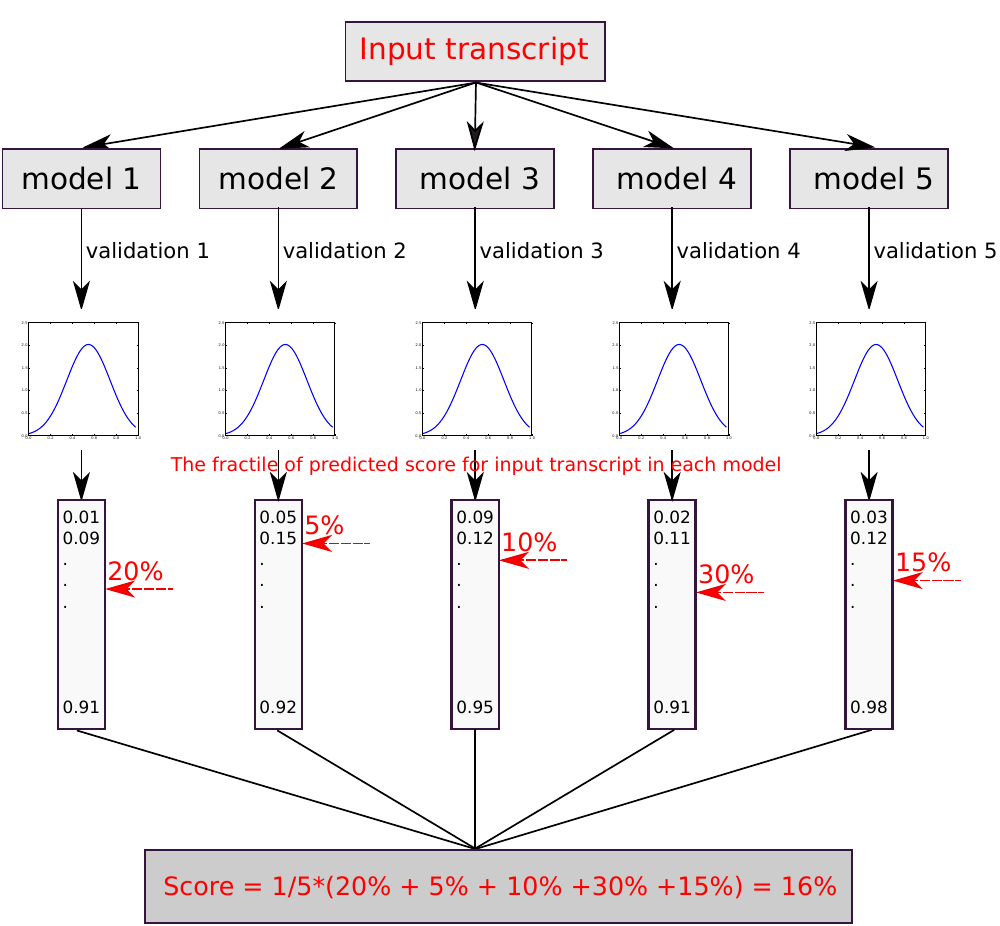
Figure 2. The flowchart illustrates how the final fractile score of the input sequences is obtained. Each model predicts a score which is then converted into a fractile. Novel sequences not in the validation sets are scored relative to the fractile in each model and then averaged over all five